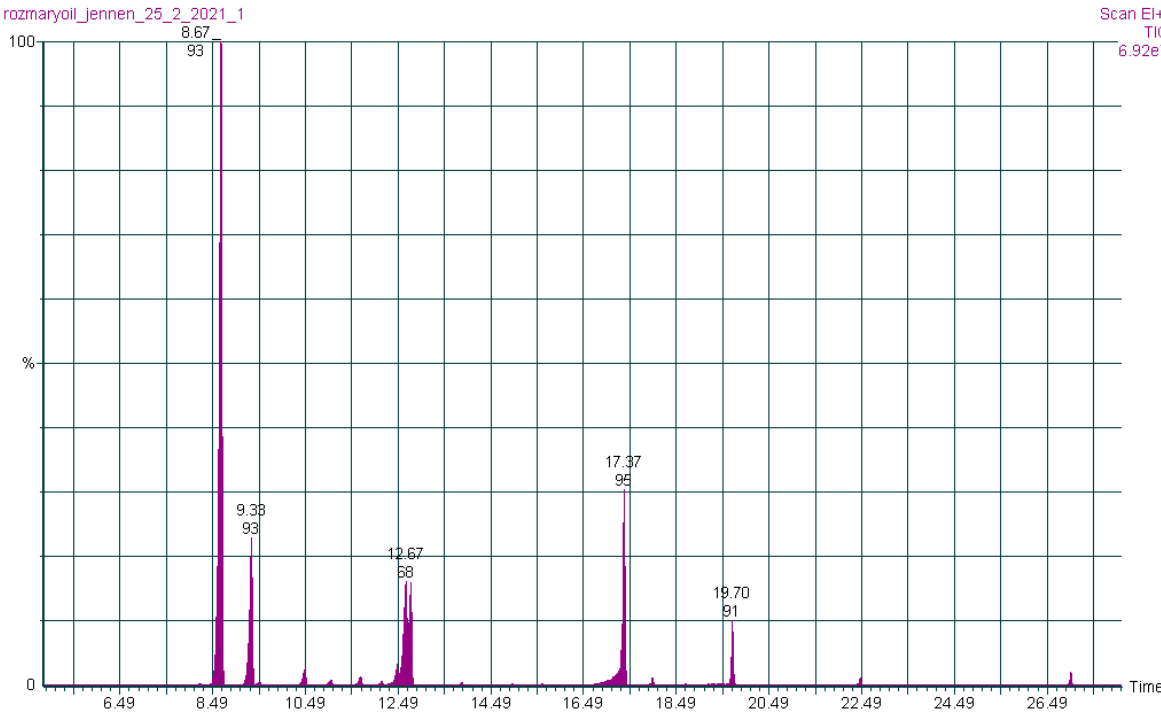
Figure 1. Gas chromatography chromatogram of R. officinalis Leaves essential oil collected in Jenin.